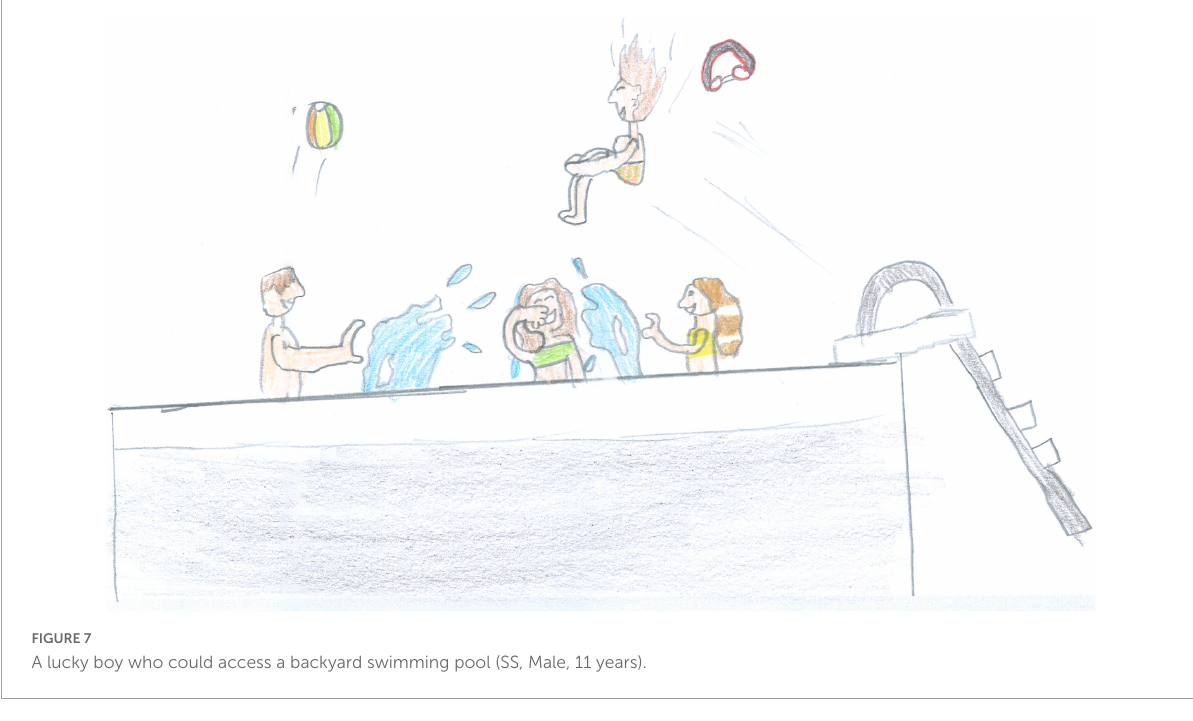
FIGURE7 A lucky boy who could access a backyard swimming pool (SS, Male, 11 years).